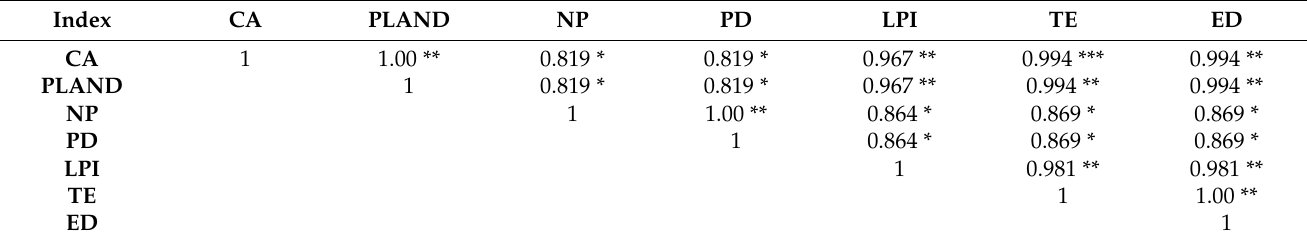
Table A3. Pearson Correlation Coefficients of the Area and Edge Metrics.